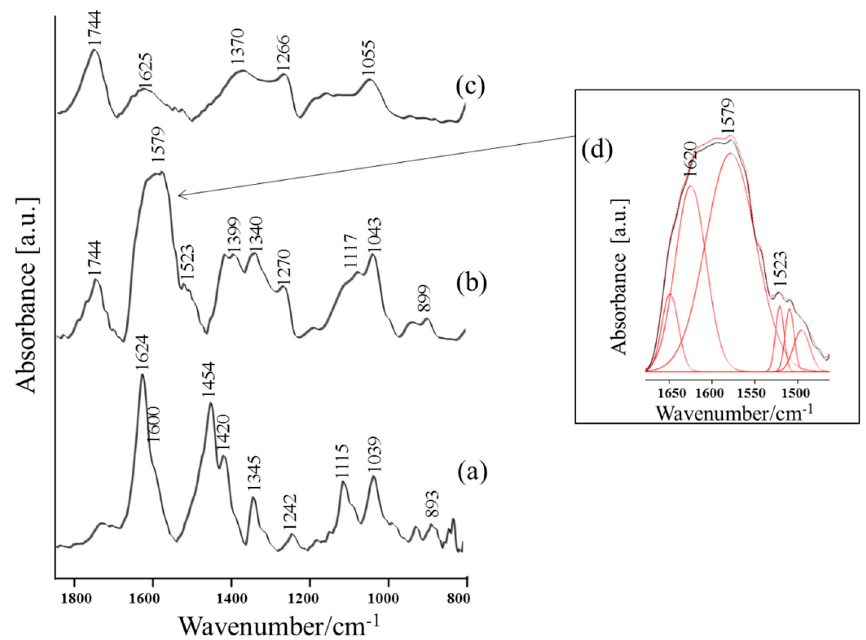
Figure 4. ( a ) FT-IR spectrum of Thr (10 − 1 M in 0.5 M HCl); ( b ) SEIRA spectra of Thr (10 − 1 M); ( c ) Thr (10 − 3 M) adsorbed onto the corroded CuNPs-Fe surface. Measurement conditions: spectral range, 1850–800 cm − 1 , MCT detector. ( d ) Inset: the deconvolution SEIRA spectrum; spectral range, 1680–1460 cm − 1 .